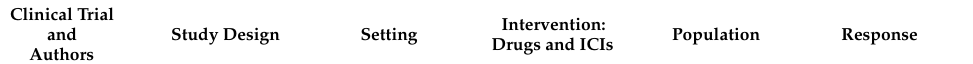
Table 3. Clinical trials in